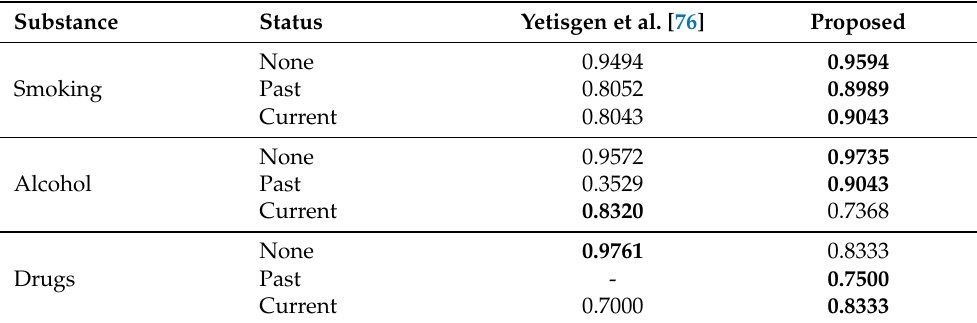
Table 9. Performance comparison in terms of F1-score on the MTSamples dataset.